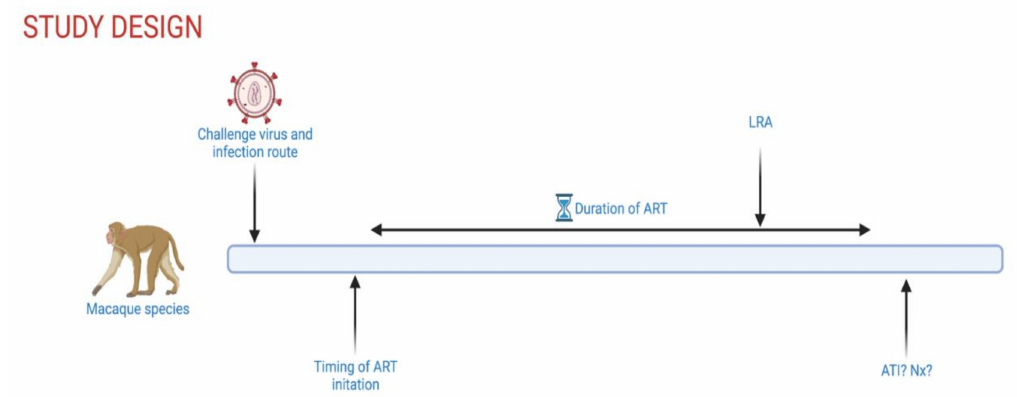
Figure 1. Schematic overview of controllable experimental parameters in NHP HIV-1 cure studies. ART, antiretrovi- ral therapy; LRA, latency reversing agent; ATI, analytical treatment interruption; Nx, elective necropsy. Created with